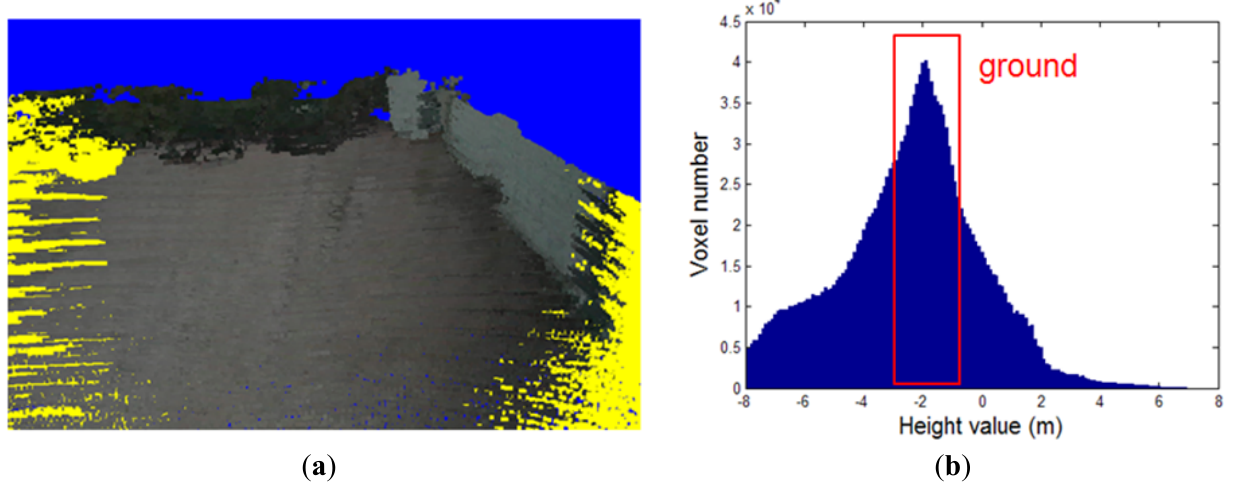
Figure 4. Height histogram generated from voxels in the voxel map. ( a ) The voxel map. ( b ) The height histogram of the voxel map in